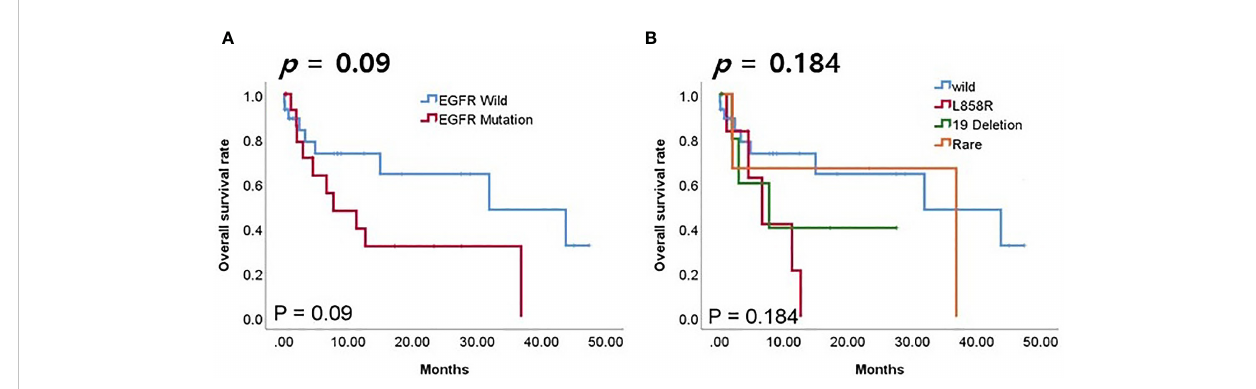
FIGURE 6 Survival analyses according to EGFR mutation in patients receiving PD-1/PD-L1 inhibitors. (A) Overall survival (OS) according to EGFR mutation. (B) OS according to EGFR mutation